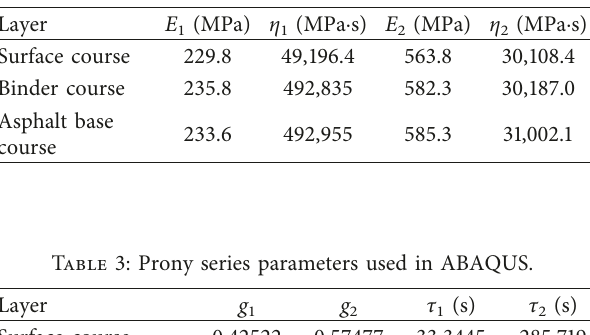
Table 2: Material parameters of the Burgers model used in SAFEM.